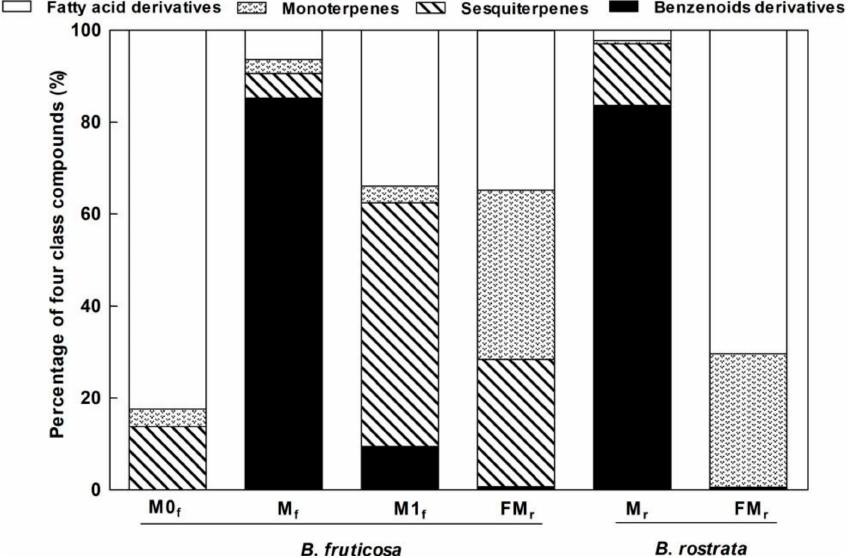
Figure 2. Relative quantity (%) of volatile compounds of four chemical classes emitted by the male and female flowers of the two Breynia species